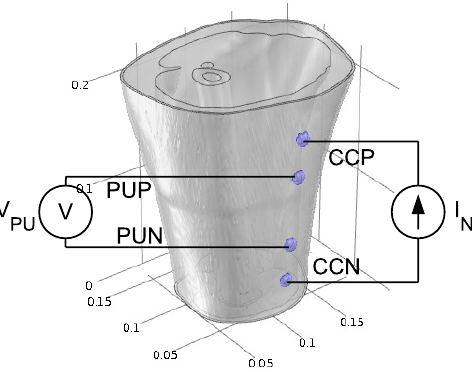
Fig. 22: Normal 4-electrode transfer impedance measurement set-up with current stimulus on the outer electrodes and voltage measurement on the inner electrodes. This is a real-world